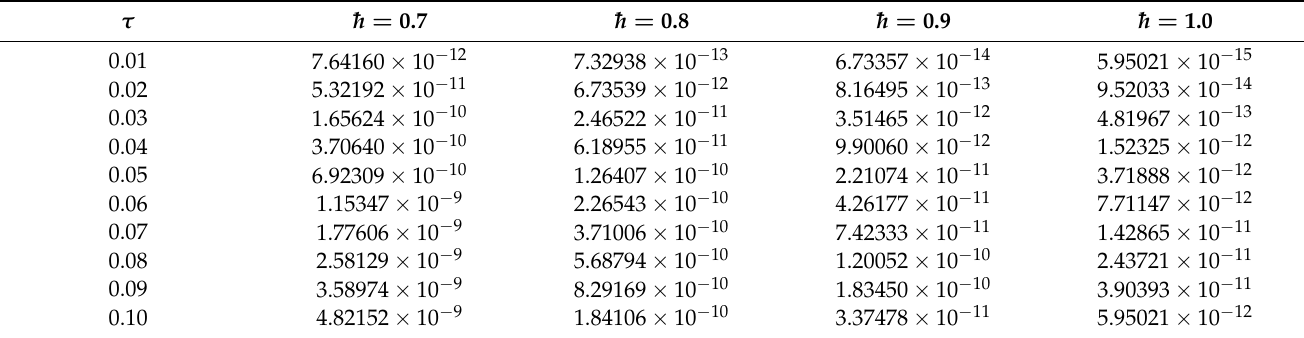
Figure 2. In Figure 2, the 2D curve of the | Ω ( α , τ ) − Ω 5 ( α , τ ) | in the range τ ∈ [ 0, 0.5 ] , when ¯ h = 1.0 for ( a ): Problem 1, when α = 0.002; ( b ): Problem 2, when α = 1.0; ( c ): Problem 3,when α = 1.0 and ξ = 2.0. Table 1. The | Ω 4 ( α , τ ) − Ω 3 ( α , τ ) | of Problem 1 at varying values of ¯ h at α = 0.002 determined by the ARPSM at plausible locations in the range τ ∈ [ 0, 0.10 ] .